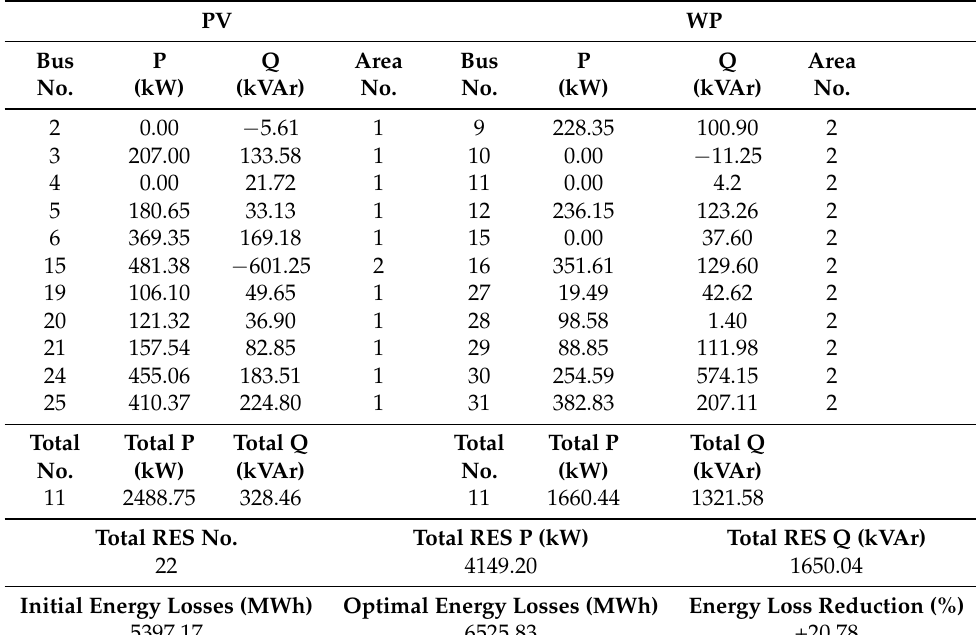
Table 12. Snapshot approach—Max Value—Scenario